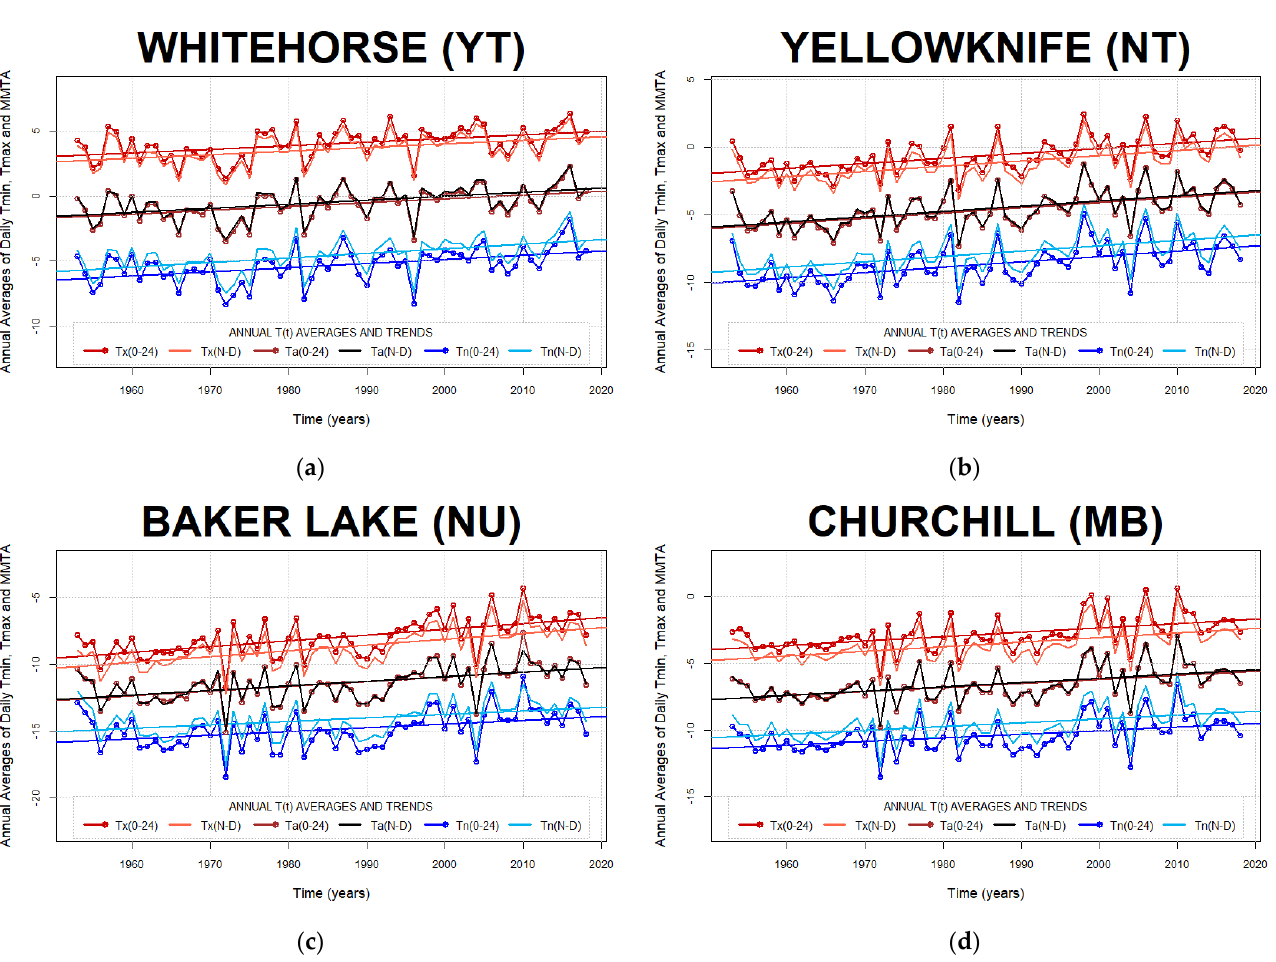
Figure A12. Northern Canada climate region. Effect of the observing window on long-term air temperature averaging at Whitehorse ( a ), Yellowknife ( b ), Baker Lake ( c ), and Churchill ( d ) stations. Annually averaged diurnal air temperature minima, maxima, and Min-Max averages obtained with COW 0–24 and COW N–D air temperature approximating methods.